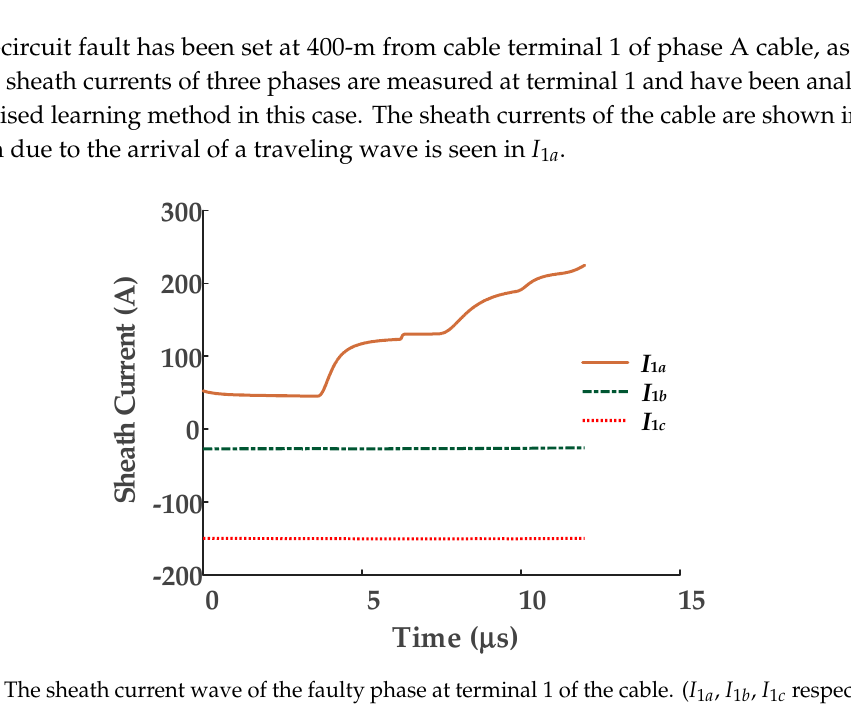
Figure 7. The sheath current wave of the faulty phase at terminal 1 of the cable. ( I 1 a , I 1 b , I 1 c respectively represent the sheath currents recorded by the current sensors on phases A, B, and C).